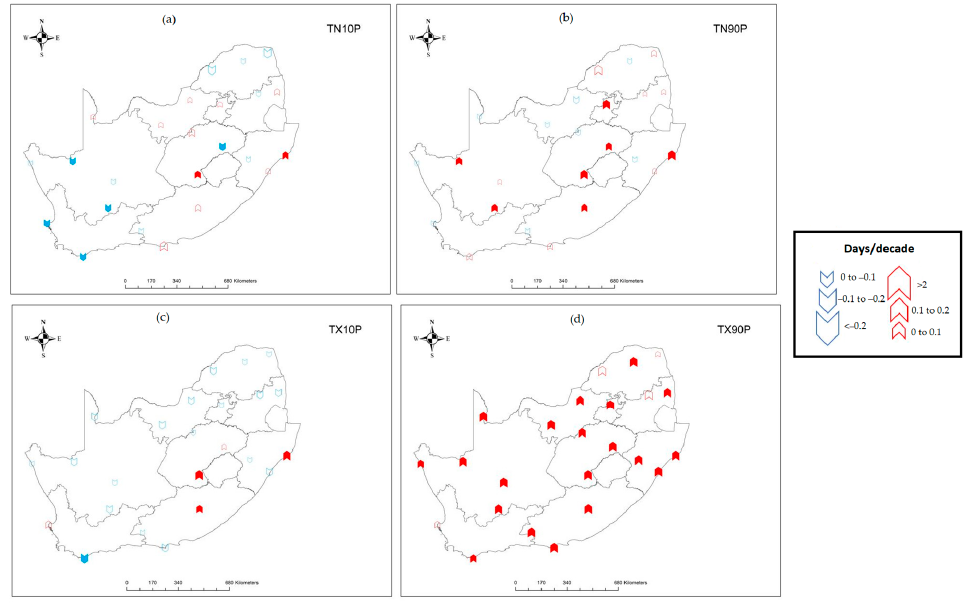
Figure 3. Temperature trends for ( a ) TN10P, ( b ) TN90P, ( c ) TX10P, and ( d ) TX90P for selected stations from 1981 to 2020 (bold arrows indicates significance at the 95% level of confidence) .